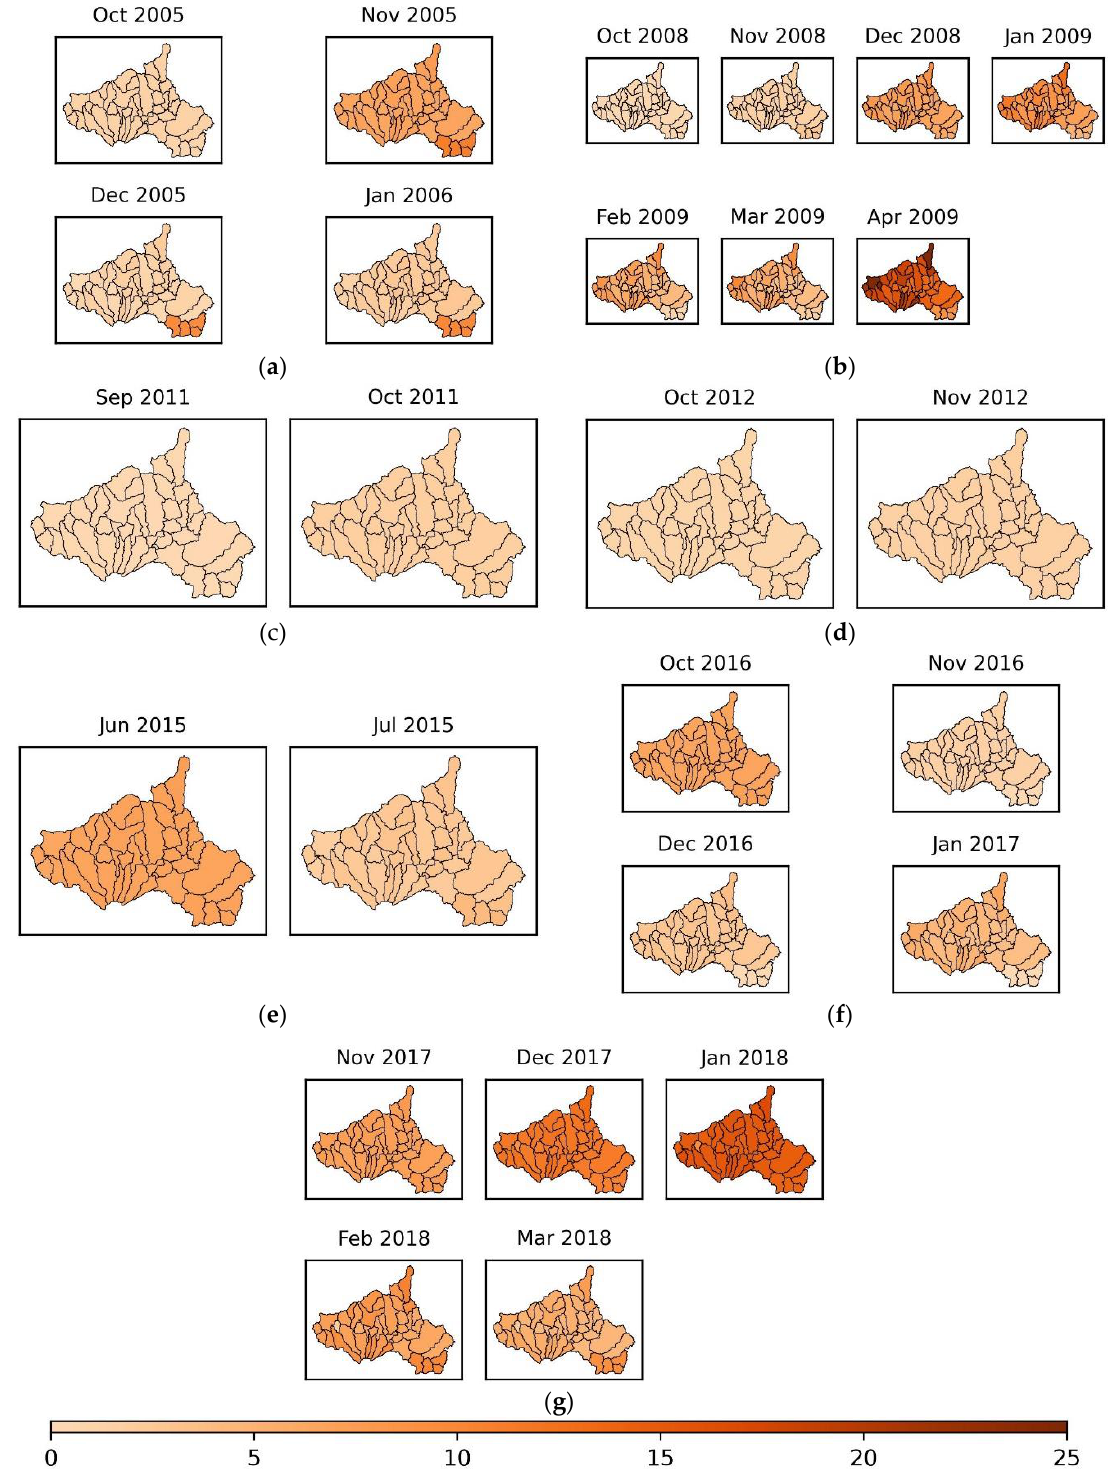
Figure 5. Monthly agricultural drought severity in mm expressed as a deviation from the threshold (baseline scenario): event I ( a ), event II ( b ), event III ( c ), event IV ( d ), event V ( e ), event VI ( f ), and VII ( g ). Higher values represent larger deviation (or moisture deficit) and more severe drought.